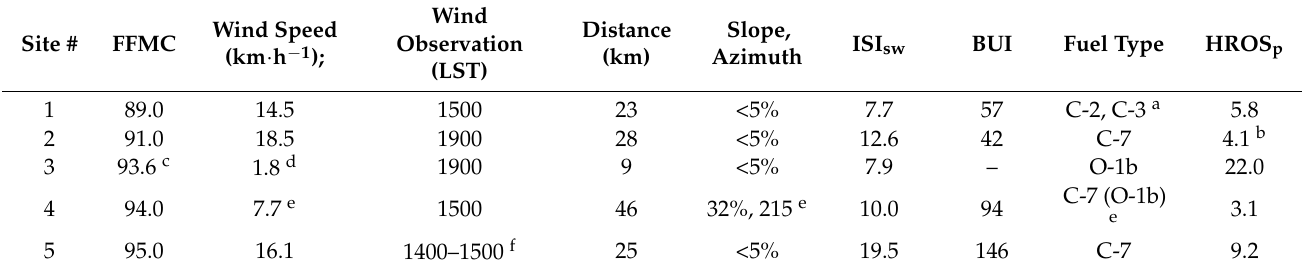
Table A1. Fire environment inputs and predicted headfire rate of spread for five example fires. ISIsw is the slope-wind adjusted ISI; and HROS p is the predicted rate of spread. Wind Distance Wind Speed Observation Site # FFMC (km) (km · h − 1 ); (LST)